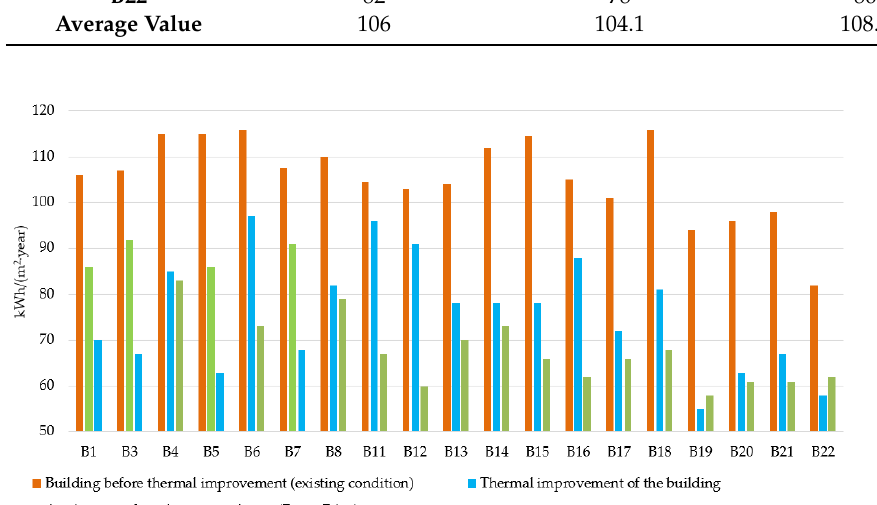
Figure 6. Structure of buildings by size of heating energy demand index before thermal im-